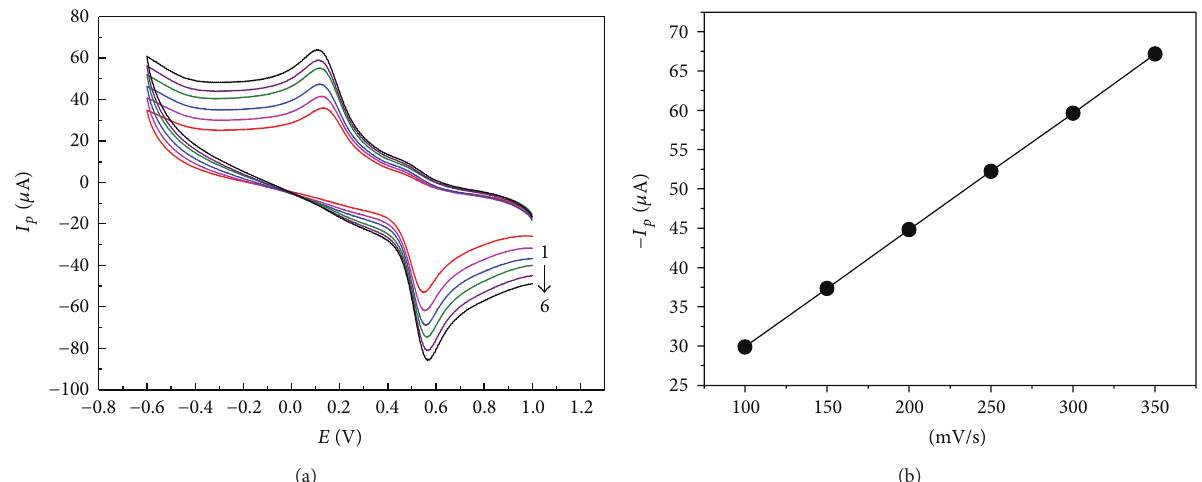
Figure 9: (a) Cyclic voltammograms under different scanning rate; (b) relation curve between hydroquinone peak current and scanning rate.